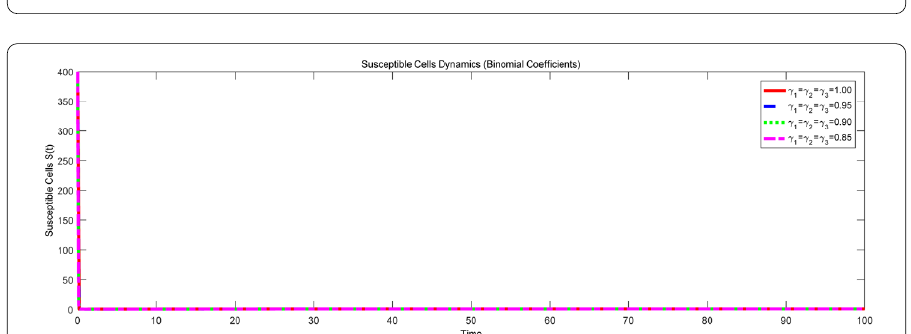
Figure 16 Dynamics of V ( t ) with γ i = 1 (solid red line), γ i = 0.95 (dashed blue line), γ i = 0.9 (dotted green line) and γ i = 0.85 (dotted dashed magenta line), i = 1,2,3.